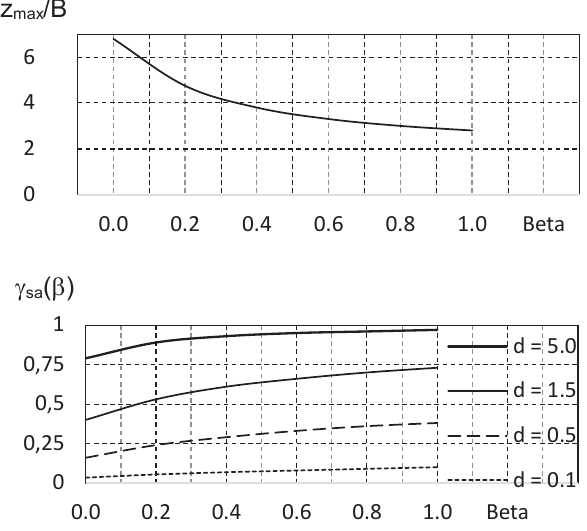
under considered foundation and max ( b ) depending on the sa (m) and the footing shape ratio b . v